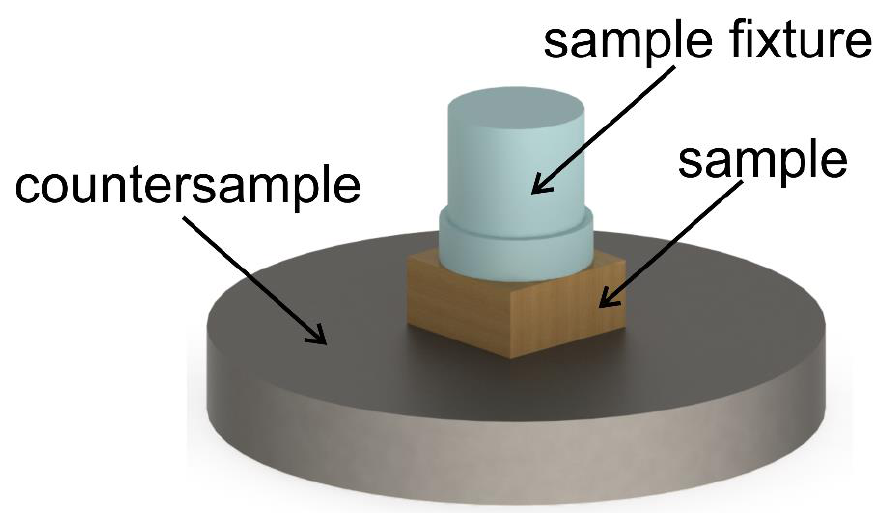
Figure 1. Friction test setup—a composite sample in the resin fixture which was needed to mount it in the apparatus.